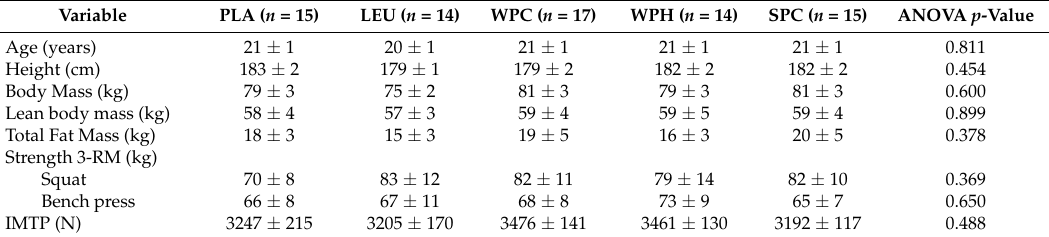
Figure 2. CONSORT diagram of the study. Legend: Details regarding this Consolidated Standards of Reporting Trails (CONSORT) diagram can be found in the results. Table 3. Baseline characteristics between